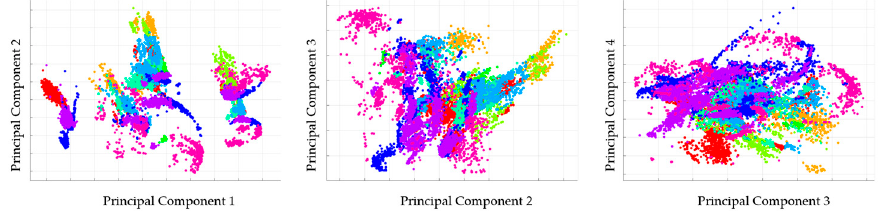
Figure 2. The pairwise scatter plots of the first four components.